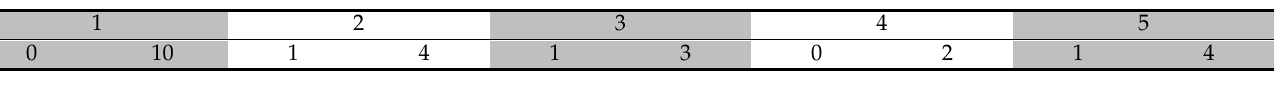
Table 3. An example of a chromosome.